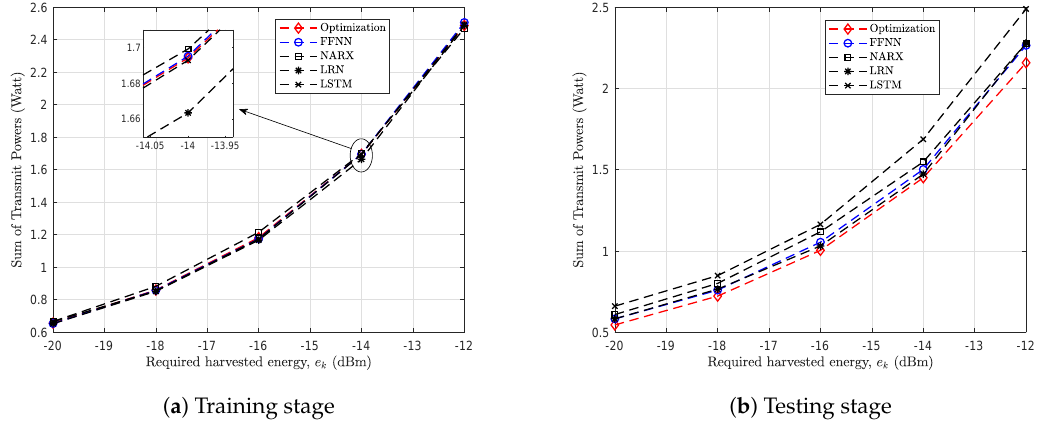
Figure 9. Sum of transmit powers according to the required energy harvesting when the required SINR is given by 2 dB ( γ k = 2 dB).